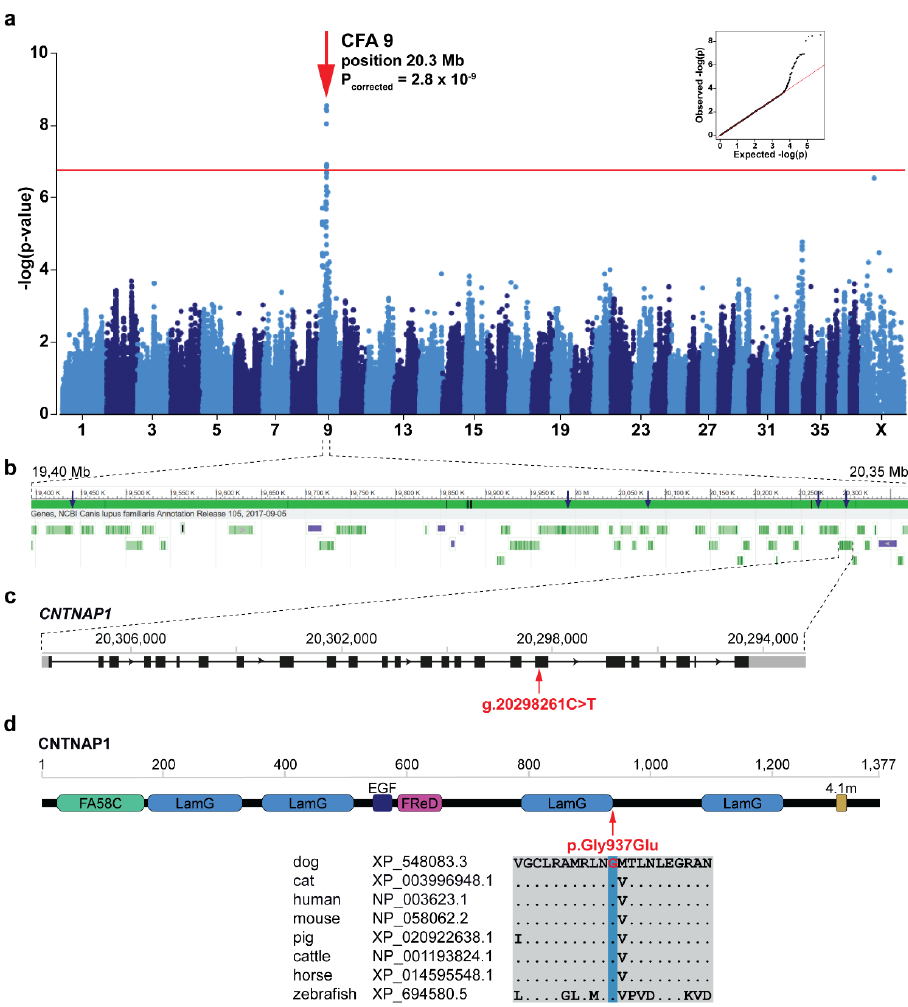
Figure 2. Identification of a new LPPN-associated locus and variant in Leonbergers and Saint Bernards. ( a ) Manhattan plot for the two-breed genome-wide association study (GWAS) using 144 LPPN-affected dogs and 373 normal control dogs indicates a signal with multiple associated single nucleotide polymorphisms (SNPs) on chromosome 9. The -log p -values for each SNP are plotted on the y -axis versus each canine chromosome on the x -axis. The red line represents the Bonferroni corrected significance threshold ( − log( p -value) = 6.76). Inset: Corrected Q–Q plot confirms that the observed p -values of the best-associated markers have stronger association with the trait than expected by chance (null hypothesis, red line). ( b ) Gene content in the ~0.98 Mb region of interest. Blue arrows show the best-associated markers from GWAS. Green bars represent the different genes and violet bars represent lncRNAs. ( c ) Schematic representation of the CNTNAP1 gene showing the variant (XM_548083.6:c.2810G>A) location in exon 18. ( d ) Schematic representation of the CNTNAP1 protein with its domains: coagulation factor 5 / 8 C-terminal domain (FA58C), laminin G domains (LamG), calcium-binding EGF-like domain (EGF), fibrinogen-related domain (FReD), and putative band 4.1 homologues’ binding motif (4.1m). The CNTNAP1 amino acid substitution (XP_548083.3:p.Gly937Glu) position is shown together with the amino acid multiple alignment indicating the residue is highly conserved across